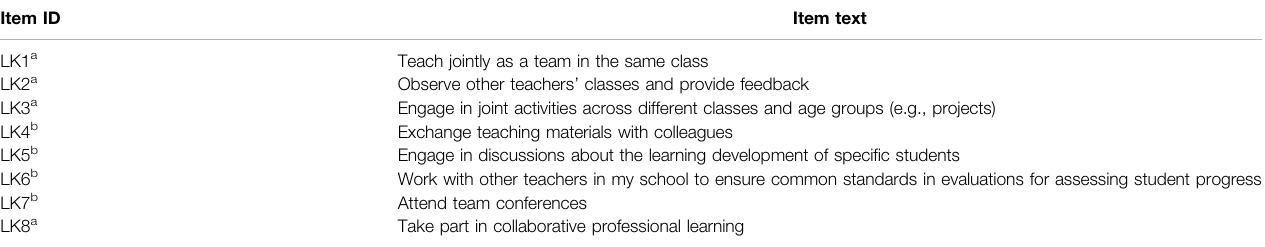
TABLE B2 | Teacher collaboration questionnaire